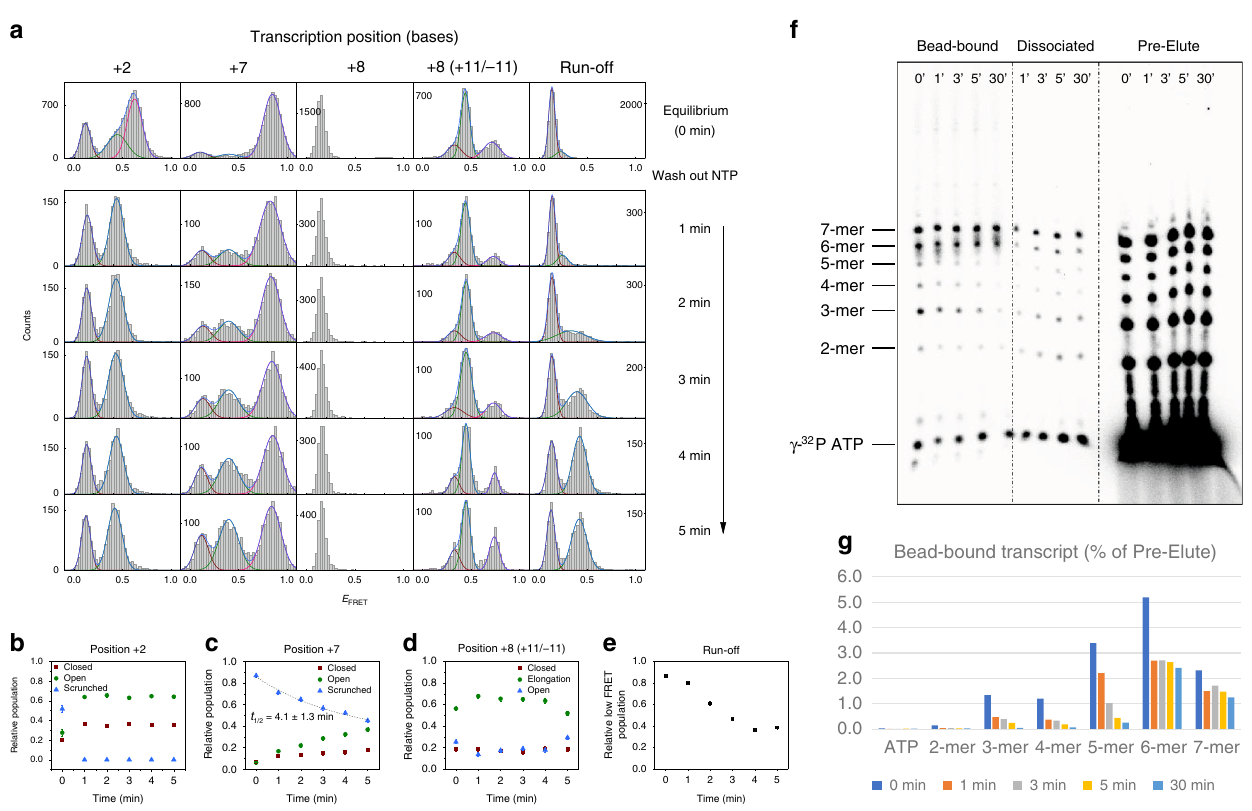
Fig. 5 The rate of abortive initiation sharply depends on the transcription position. a FRET histograms obtained at equilibrium and after washing out the NTP mixture for positions + 2, + 7, and + 8, and run-off conditions. For position + 8, results from DNA template + 11/ − 11 are included to distinguish between the populations of the elongation complex and DNA only. Each histogram was obtained from 12 short movies taken during each minute after washing out the NTP mixture (Supplementary Table 1). b , c Time traces of the relative populations of closed (low FRET), open (mid FRET), and scrunched (high FRET) complexes obtained from histograms at positions + 2 ( b ) and + 7 ( c ). Each graph was fi t to a single-exponential decay curve, and the half-life is shown. In c , the graph of the scrunched population was fi t to a single-exponential decay curve, and the half-life is shown. d Time trace of the relative populations of closed (low FRET), open (high FRET), and elongation (mid FRET) complexes obtained from histograms at position + 8 on DNA template + 11/ − 11. e Time trace of the relative low FRET population obtained from histograms under run-off conditions. In b – e , the error bars represent the error in the relative populations originating from the error in estimating the areas under the Gaussian curves. f Gel electrophoresis image of abortive transcripts from bead-based in vitro transcription assay, stalling at position + 7. Each nucleotide length is marked. The time delay between NTP washout and the collection of bead-bound transcripts is shown (0 – 30 min). The experiment was repeated three times showing similar results. g Quanti fi ed percentage of bead-bound transcripts over transcripts in pre-elute, which are the products from 15 min transcription reaction before NTP